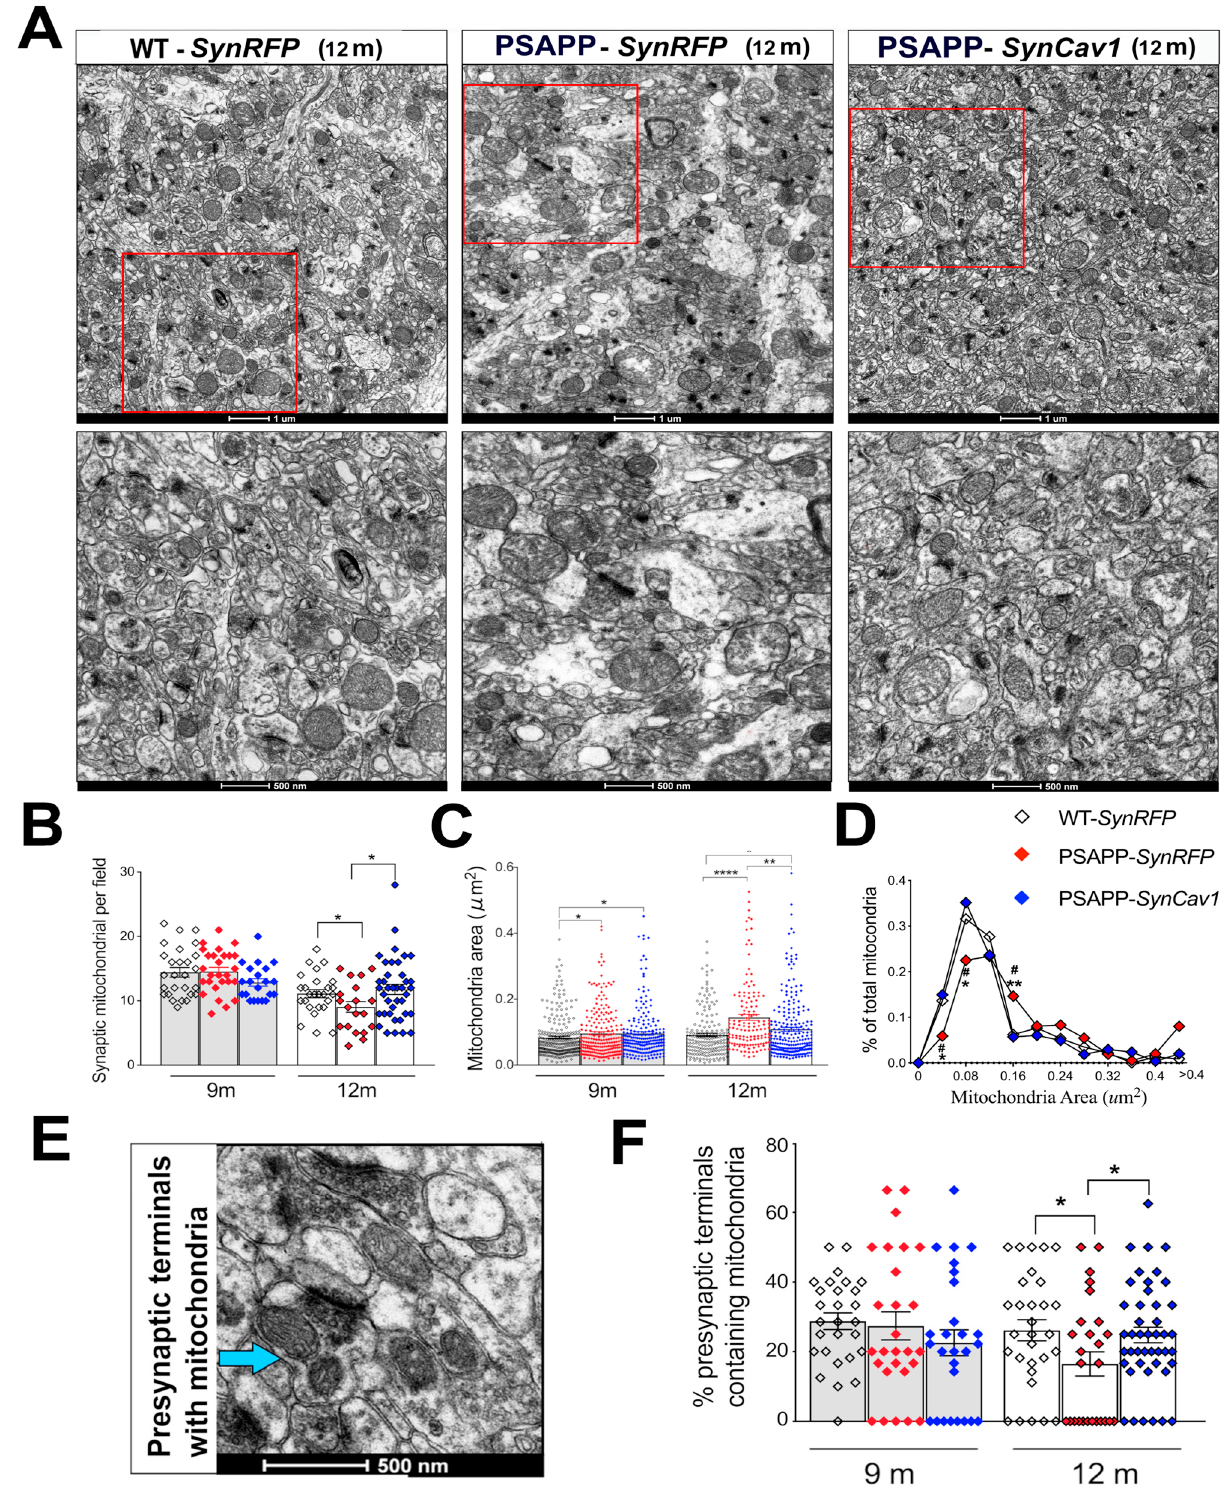
Figure 3. SynCav1 preserves synaptic mitochondrial number and morphology in PSAPP mice . ( A ) Representative images of synaptic mitochondria in CA1 distal apical dendrites within the stratum radiatum with high magnification of representative region at 12 m. Quantitation of synaptic mitochondrial number and area ( B , C ) and % of total mitochondria relative to the area ( D ). Representative image and quantification ( E , F ) of mitochondria-containing pre-synaptic terminal. Data are presented as mean ± S.E.M., n = 5–7 animals per group with 10 micrographs per animal. Data were analyzed using One-Way ANOVA. Significance was assumed when p < 0.05. * p < 0.05, ** p < 0.01, **** p < 0.0001.